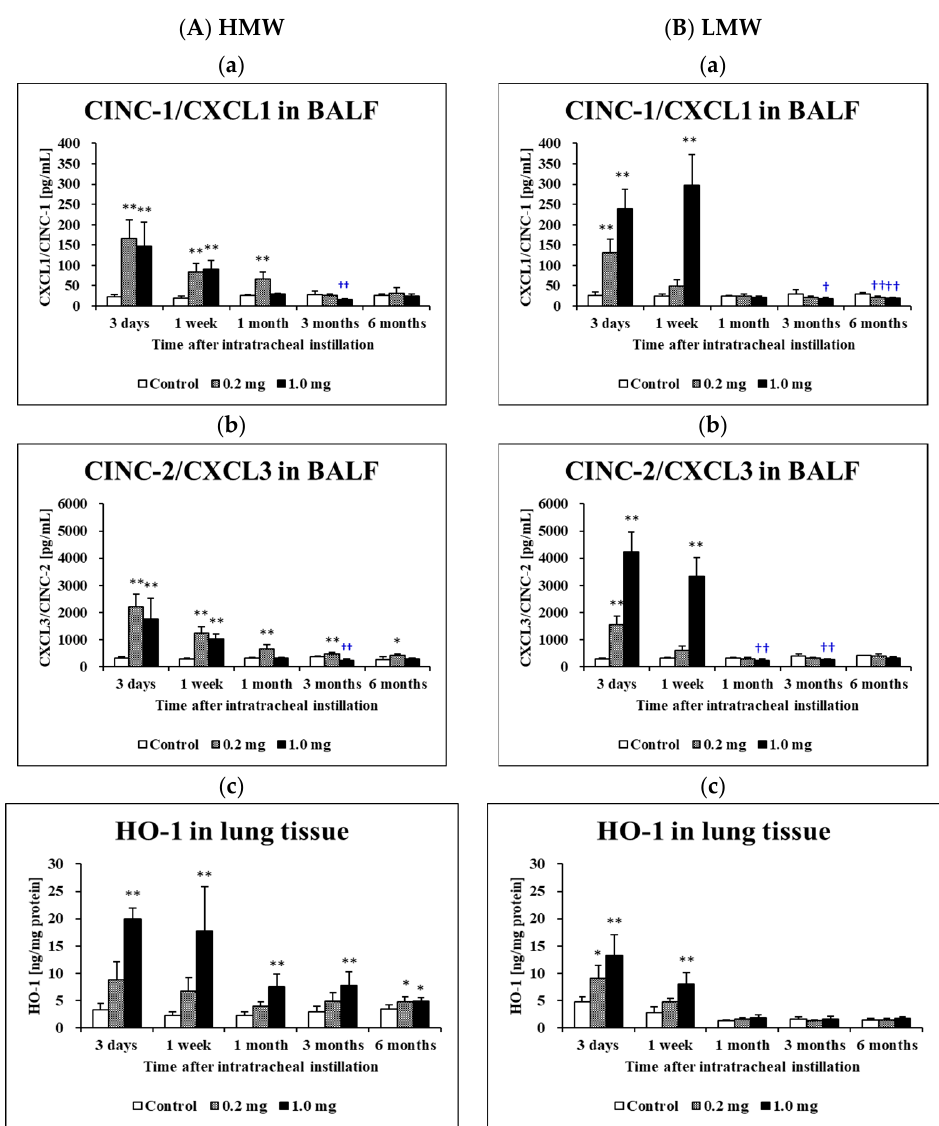
Figure 5. Analysis of cytokines in BALF and HO-1 in lung tissue after intratracheal instillation ( A ) HMW PAA-exposure group and ( B ) LMW PAA-exposure group, where ( a ) CINC-1/CXCL1 concentration in BALF, ( b ) CINC-2/CXCL3 concentration in BALF, and ( c ) HO-1 concentration in lung tissue. In the HMW PAA-exposure group, high expression of CINC-1/CXCL1 and CINC-2/CXCL3 in BALF was persistent from 3 days to 1 or 3 months after the instillation, whereas in the LMW PAA-exposure group, it was persistently only from 3 days to 1 week after the instillation. In the HMW PAA-exposure group, high expression of HO-1 was sustained throughout the observation period, but in the LMW PAA-exposure group it was sustained for only 1 week after the instillation. Data are presented as mean ± SE. (* p < 0.05 and ** p < 0.01 indicate that the values are significantly higher than control group. † p < 0.05 and †† p < 0.01 indicate that the values are significantly lower than control group.).